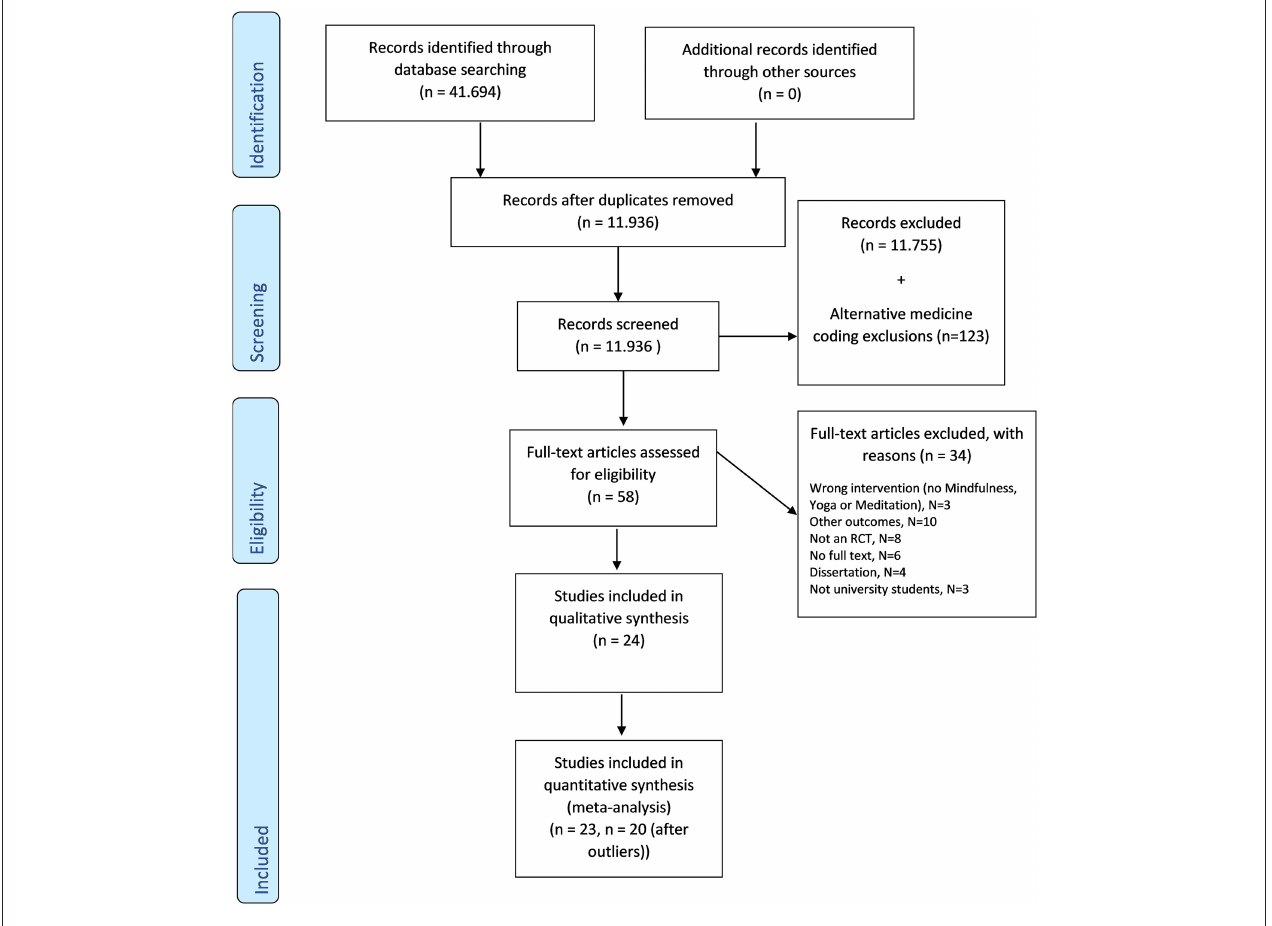
FIGURE 1 | Prisma-P flow chart.